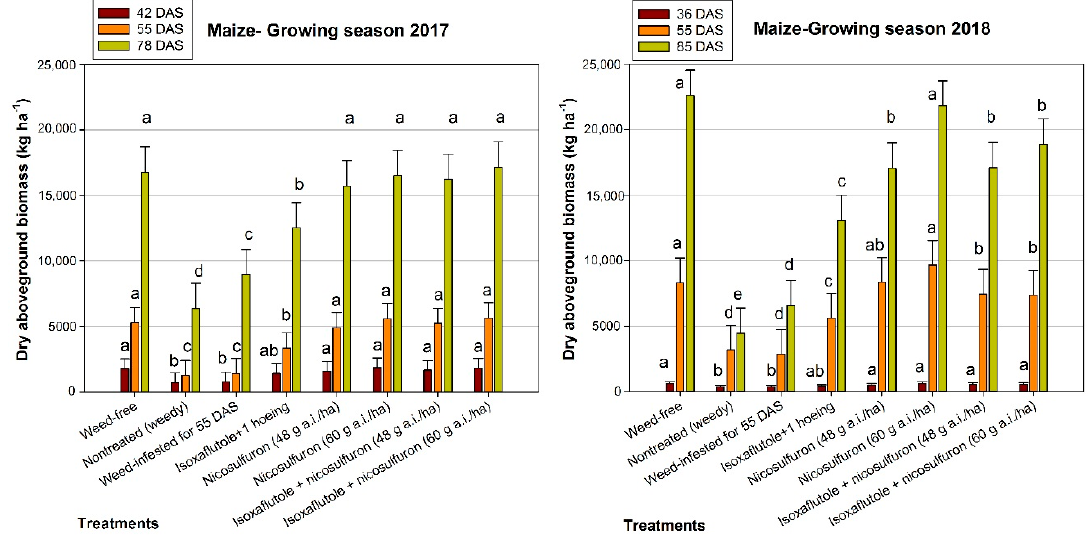
Figure 5. Maize aboveground biomass as affected by the various treatments at 36–42 days after sowing (DAS), 55 DAS, and 78–85 DAS, in 2017 and 2018 (Velestino, Greece). For each measurement, bars followed by different letters indicate significant differences according to Fisher’s LSD test ( p ≤ 0.05). Error bars indicate the LSD 5% values.